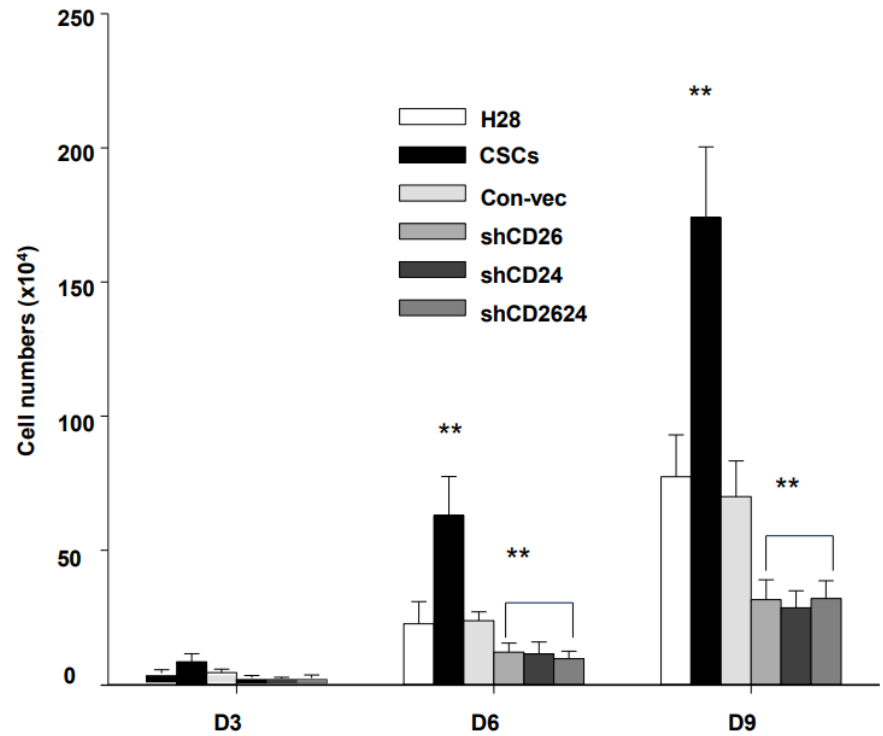
5 of 16 Figure 3. Cell invasion potential of MM cell lines. Cell invasiveness was determined by using a